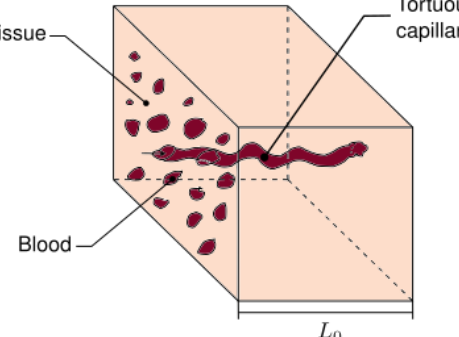
Figure 3. Representative elementary volume of human